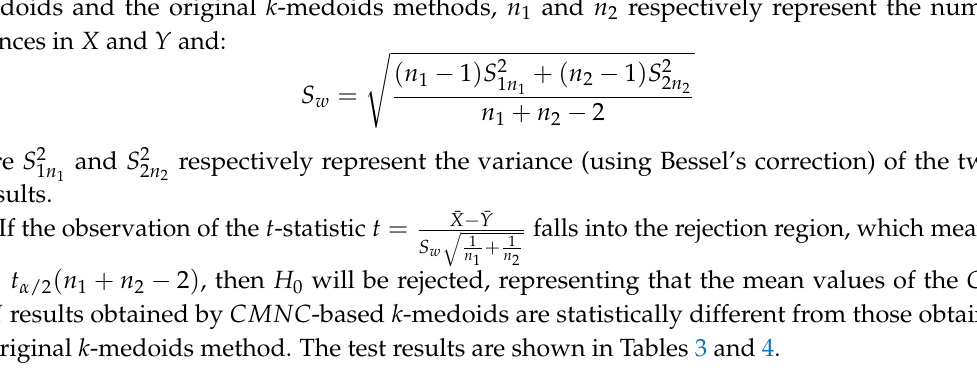
Table 3. Significance test of CE results: CMNC -based k -medoids vs. k -medoids.